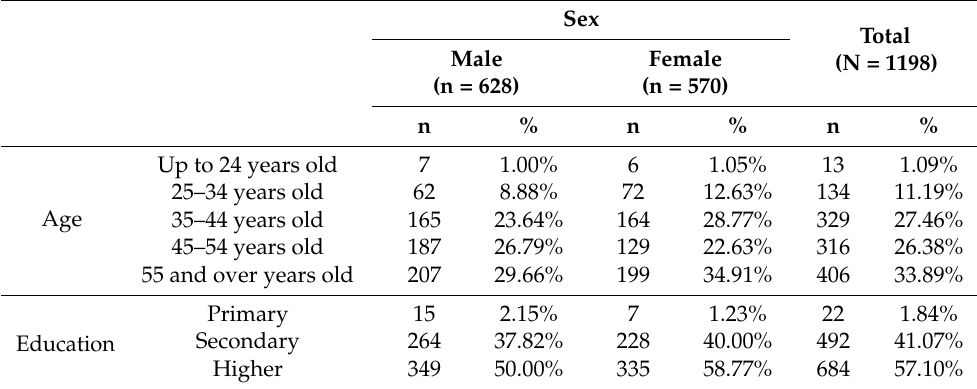
Table 1. Respondents by gender, age, and education.